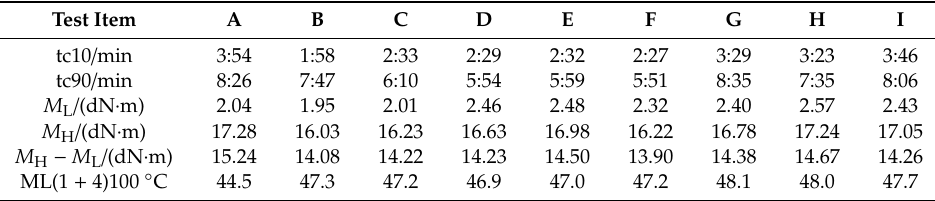
Table 3. Processing properties of composite materials.